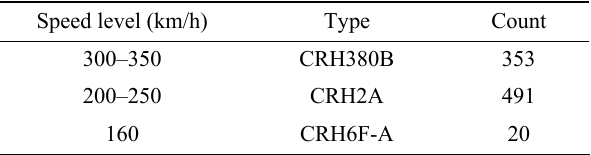
Table 1 Type of CRH in leading service counts among every speed level [162].